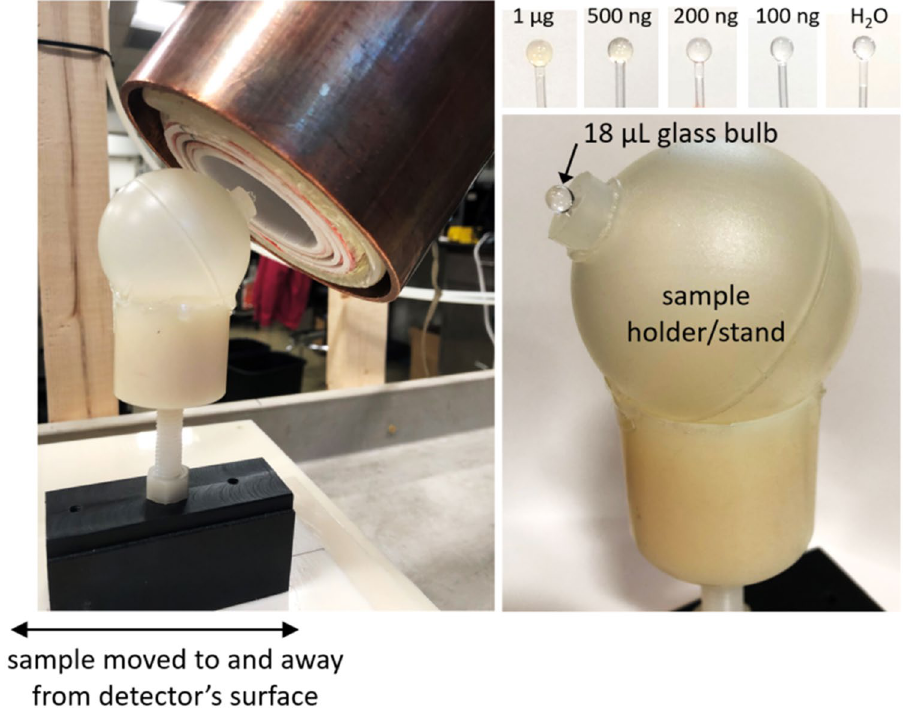
Figure 5. Experimental setup for surface detection. A plastic stand holds the glass bulb SPIO samples, and the detector is positioned such that the samples are approximately at the center of the surface/end plane of the coils. The detector’s mounting arm can be tightened so that it stays in place. The holder can be moved up to and away from this position in a repeatable manner. Samples between 1 µg and 100 ng Fe are tested as well as a control bulb filled only with DI H 2 O (data shown in Fig.